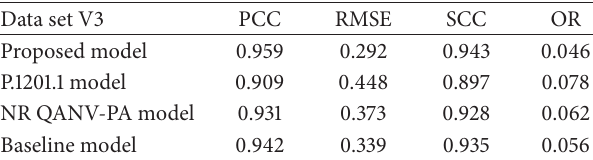
Table 11: Performance comparison between objective data and subjective